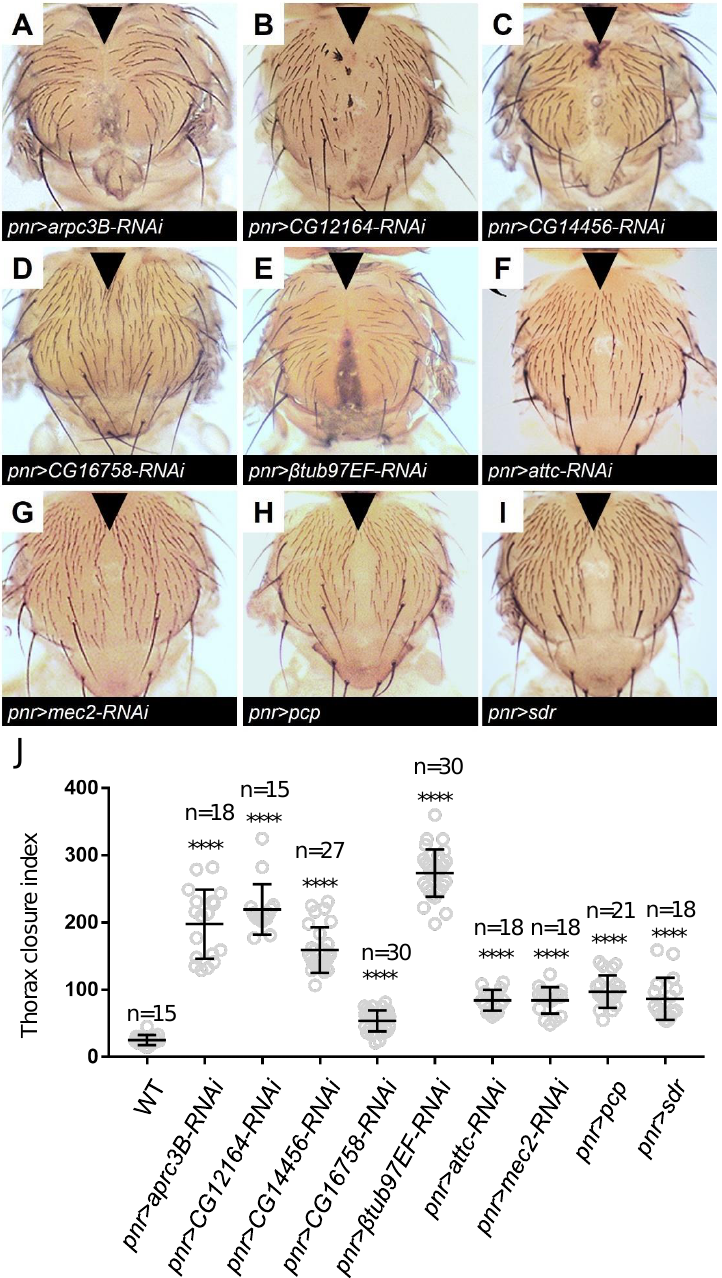
Figure 4. Adult thorax phenotype of nine potential Doc target genes. ( A – G ) Severe thorax closure defect when knocking down arpc3B ( A ), CG12164 ( B ), CG14456 ( C ), CG16758 ( D ), β tub97EF ( E ), attc ( F ) and mec2 ( G ). Severe thorax closure defect upon overexpression of pcp ( H ) and sdr ( I ). The black arrows indicate the success of thorax closure. The black triangles indicate the failure of thorax closure. Scale bar, 200 µ m. ( J ) Quantification of the thorax closure severity indicated by the thorax closure index. Asterisks indicate the significant differences determined by Student’s t test. ****, p <